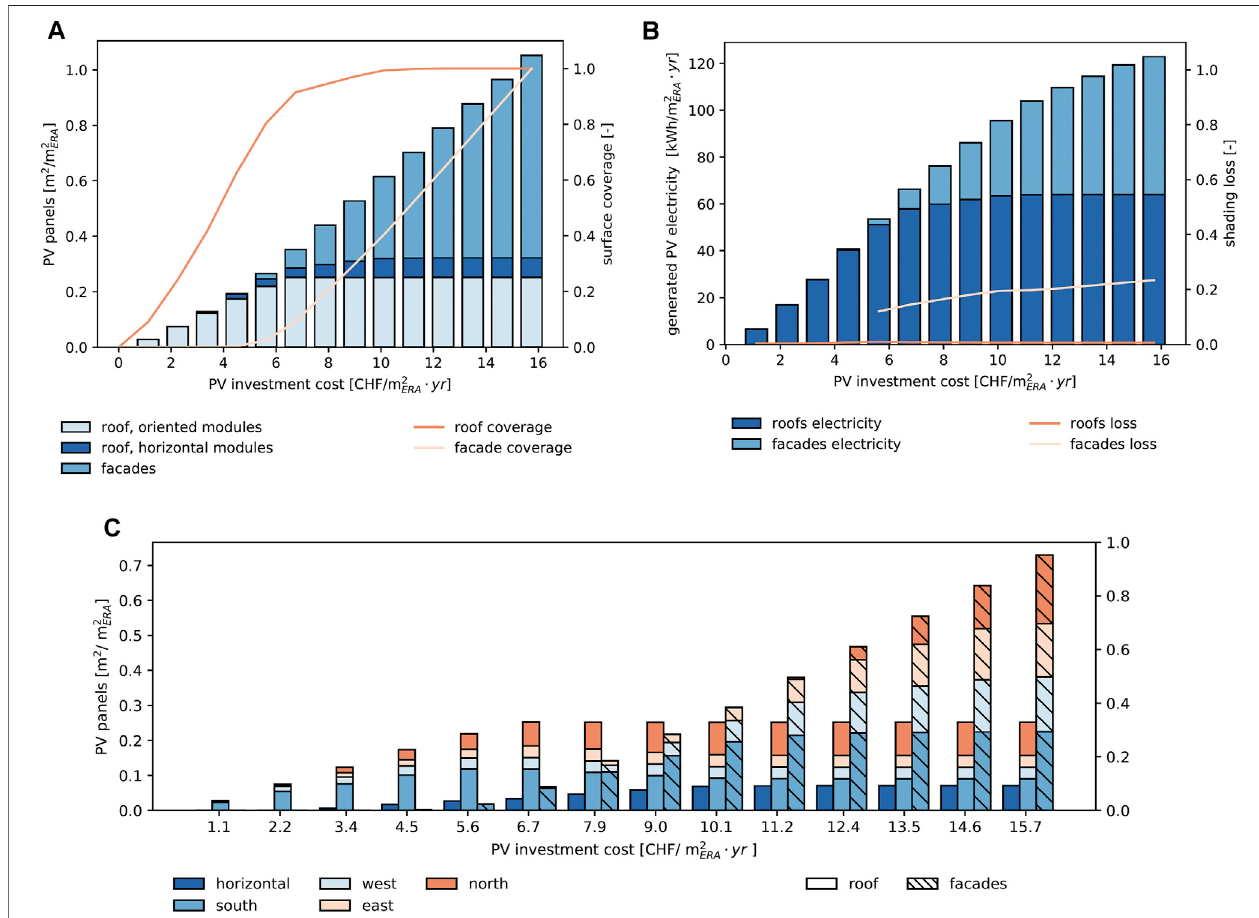
FIGURE5| EconomicallybestPVinstallationfor31residentialbuildings,normalizedtototalenergyreferencearea(ERA)inthedistrict. (A) Areaofinstalledmodules sorted by orientation type, PV modules with tilt (cid:1) 0 ◦ are horizontal, tilt angles (cid:1) 90 ◦ are facades, and oriented modules summarize all other tilt angles. (B) Annual generated electricity and shading losses depending on surface type. (C) Area of installed PV sorted by sky direction. Aggregated azimuth angles: 316 ° - 45 ° North, 46 ° - 135 ° East, 136 ° -225 ° South, 226 ° -315 ° West.